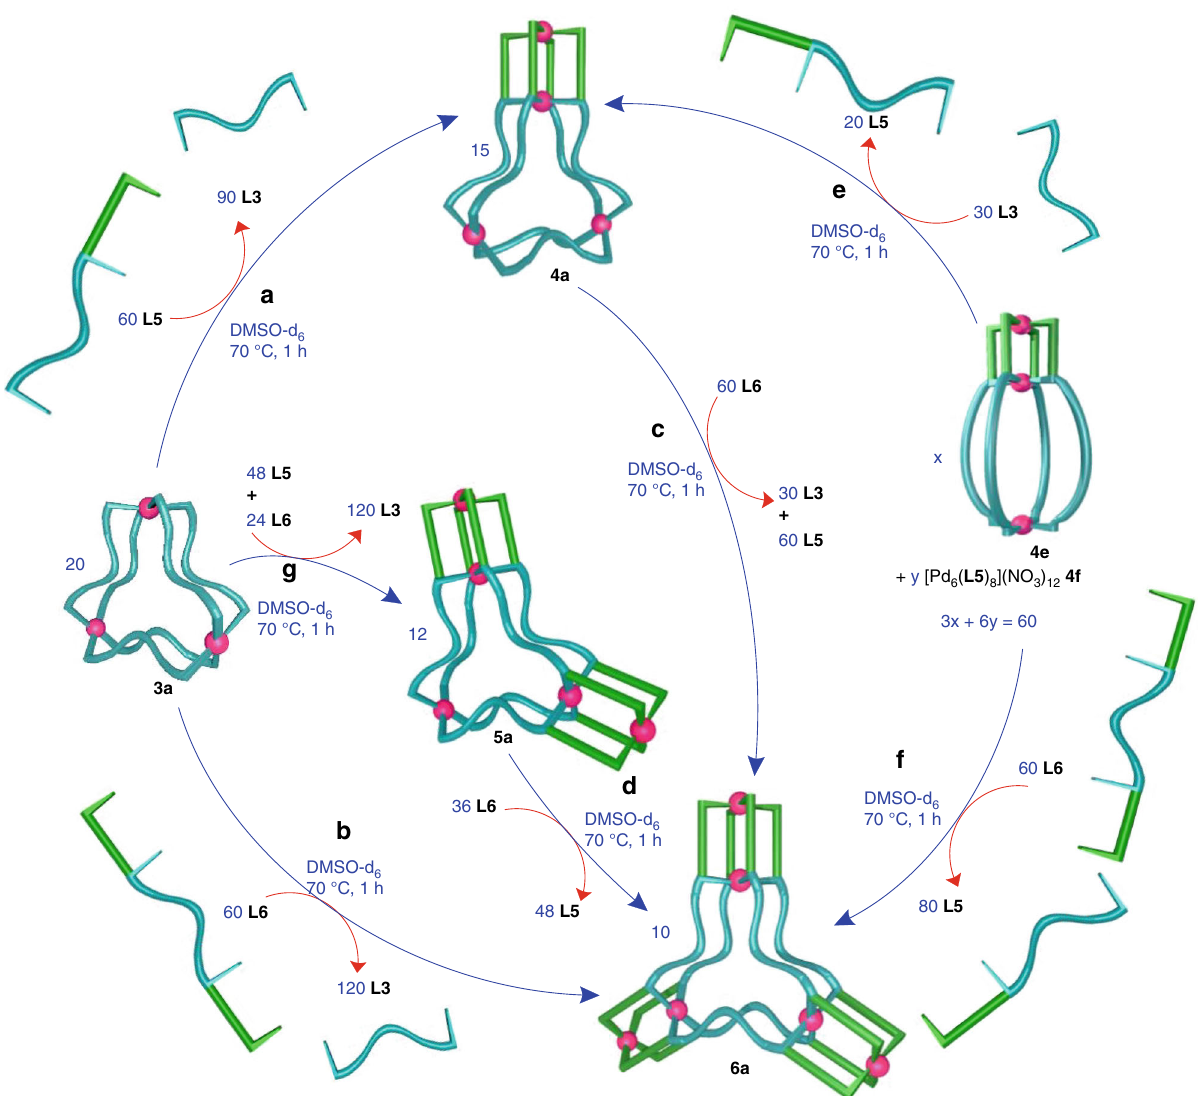
Fig. 6 Ligand-displacement-induced cage-to-cage transformations. Initial-cage/ligand-input/ fi nal-cage/displaced-ligand a system 3a / L5 / 4a / L3 ; b system 3a / L6 / 6a / L3 ; c system 4a / L6 / 6a / L3 & L5 ; d system 5a / L6 / 6a / L5 ; e system 4e / L3 / 4a / L5 ; f system 4e / L6 / 6a / L5 ; g system 3a / L5 & L6 / 5a / L3 (stoichiometry are provided in the fi gure. The complex 4e coexists with 4f (ethyl acetate:hexane, 4:6) yielded the ligand L2 as a colorless liquid (0.288 g, yield 80%) (see Supplementary Figs. 1 – 6). TLC (ethyl acetate:hexane, 40:60 v/v): R f = 0.4; 1 H NMR (500 MHz, DMSO- d 6 , room temperature): δ 9.12 (d, J = 1.3Hz, 1H, H f2 ), 8.82 (dd, J 1 = 4.8Hz, J 2 = 1.6 Hz, 1H, H i2 ), 8.72 (d, J = 1.4Hz, 1H, H a2 ), 8.57 (m, 1H, H b2 ), 8.32 (m, 1H, H g2 ), 7.93 (d, J = 7.8 Hz, 1H, H d2 ), 7.57 (m, 1H, H h2 ), 7.43 (m, 1H, H c2 ), 5.43 (s, 2H,